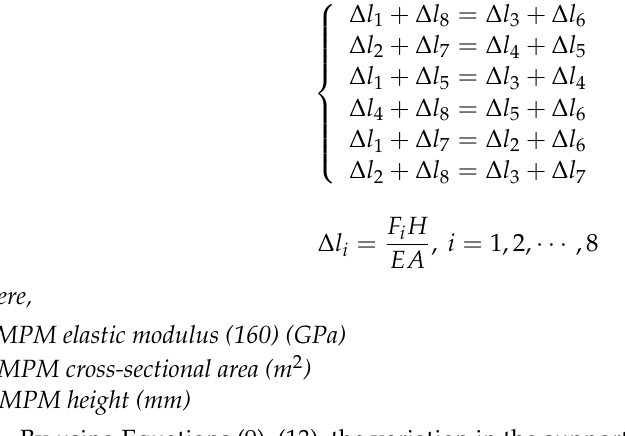
(cid:3397) 𝐹 (cid:3398) 𝑀 ⋅ 𝑔 (cid:3404) 0 (9) (cid:2875) (cid:2876) (cid:2870) (cid:3397) 𝐹 (cid:3397) 𝐹 (cid:4667) (cid:3404) 0 (10) (cid:2874) (cid:2875) (cid:2876)